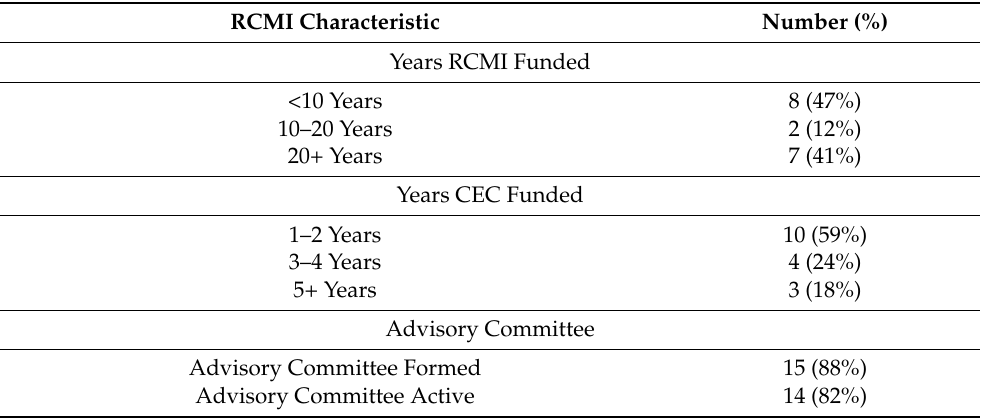
Table 1. Research Centers at Minority Institutions (RCMIs) Community Engaged Research De- scription.